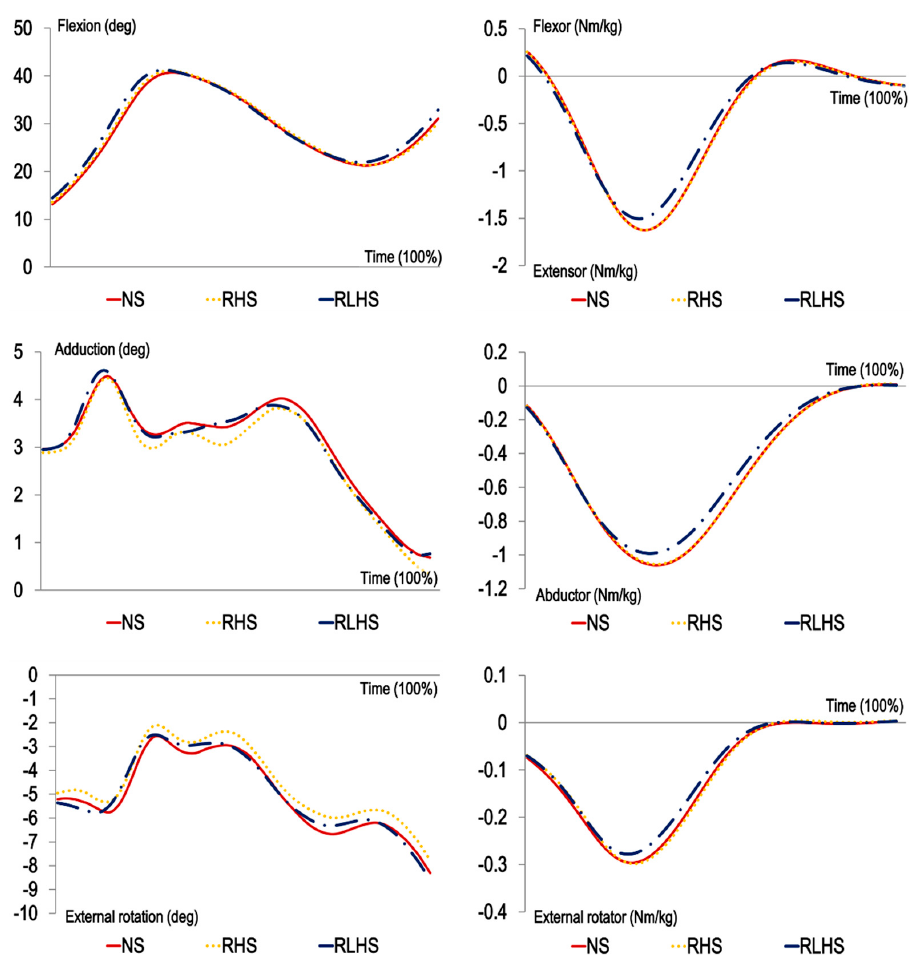
Figure A2. Comparison of knee joint angles and moments between the shoes.